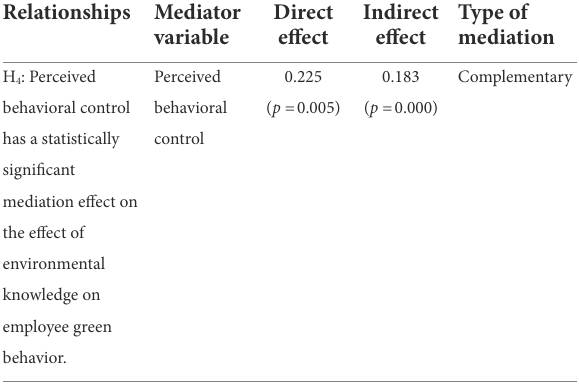
TABLE 8 Mediation relationship. Relationships Mediator